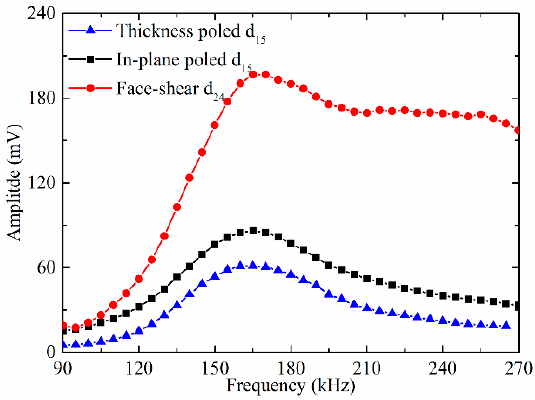
Figure 9. The amplitude of received SH 0 wave versus frequency. Signals were generated by the d 36 type PMN ‐ PT wafer under 20 V and received by different shear mode piezoelectric wafers.